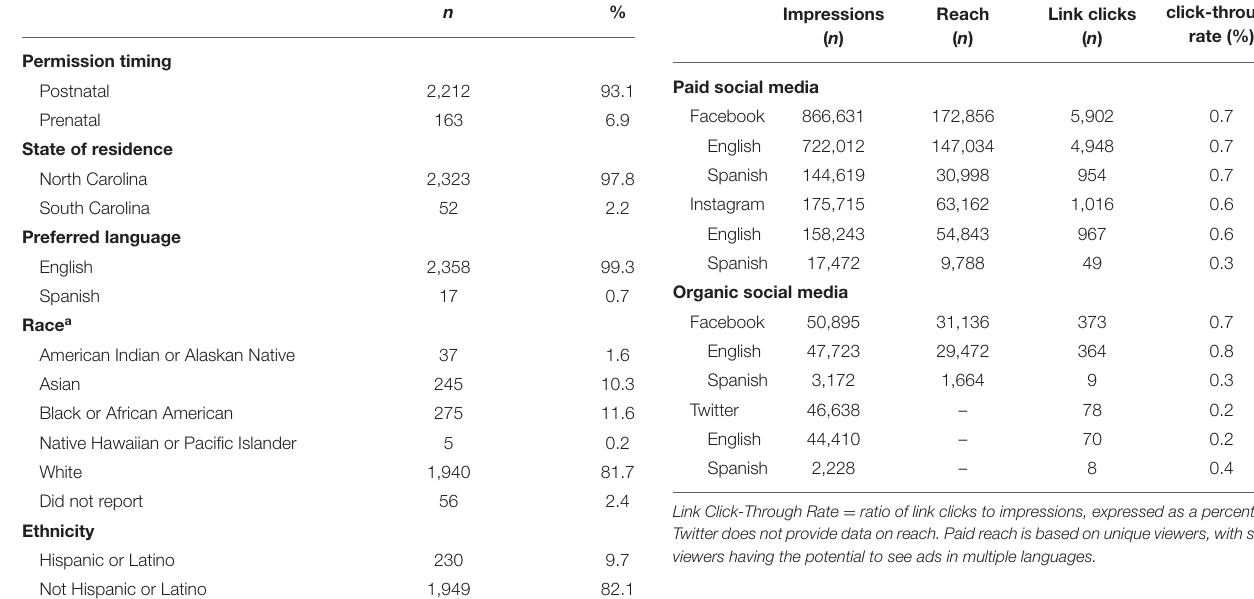
viewers having the potential to see ads in multiple